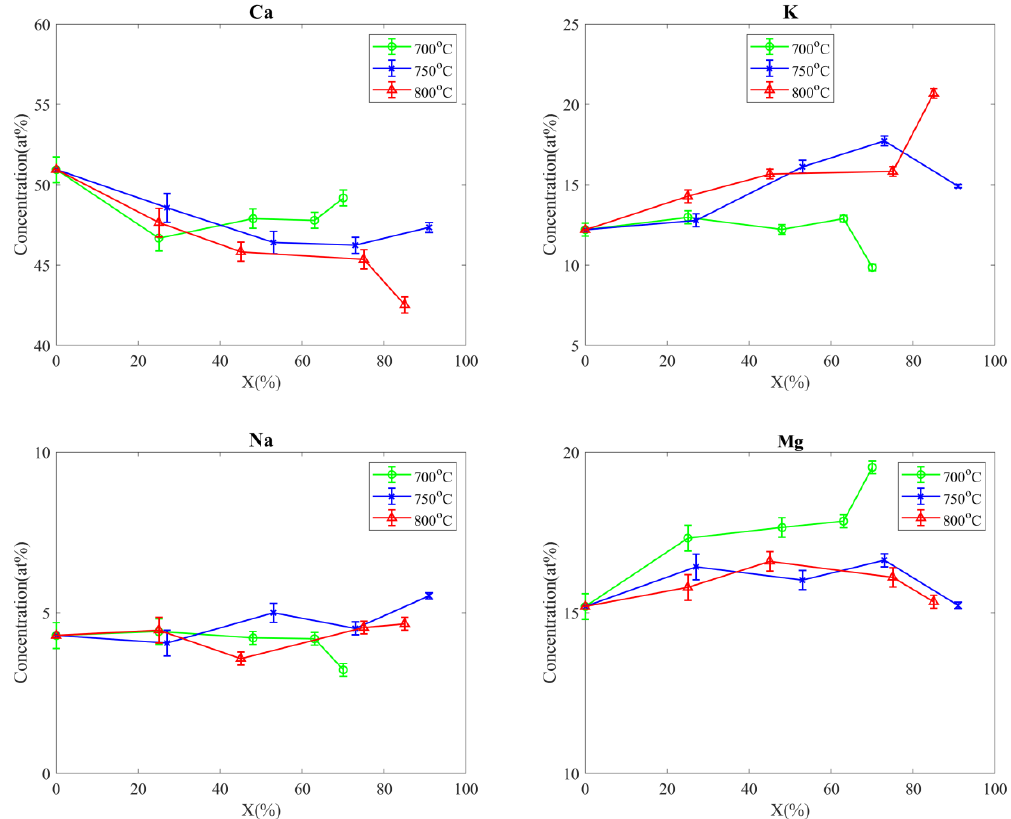
Figure 11. Surface concentrations of the alkali and alkaline earth metal (AAEM) species as a function of char conversion at different temperatures.